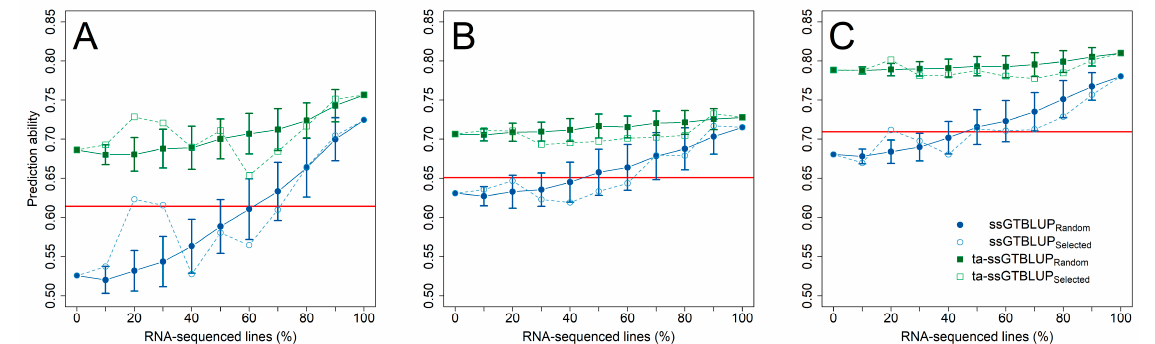
Figure 3. Prediction ability ( ± standard deviation) for the resistance against F. sporotrichioides ( A ), F. culmorum ( B ), and F. graminearum ( C ) with an increasing number of RNA-sequenced genotypes for a single-trait single-step genomic-transcriptomic prediction (ssGTBLUP) (blue circles) and a trait-assisted single-step genomic-transcriptomic prediction (ta-ssGTBLUP) (green squares) that includes pre-existing information of the secondary trait anther retention. The set of RNA-sequenced genotypes was either randomly sampled (closed symbols; solid lines) or by the partitioning around medoids method based on SNP Array markers (DNA) (open symbols; dashed lines). Single-step predictions without RNA-sequenced genotypes correspond to genomic prediction and models with a complete set of RNA-sequenced genotypes to transcriptomic predictions. Prediction models were compared with the merit of an indirect phenotypic selection based on anther retention (solid red horizontal line). All three gene expression matrices were used to fit the single-step and transcriptomic prediction models.